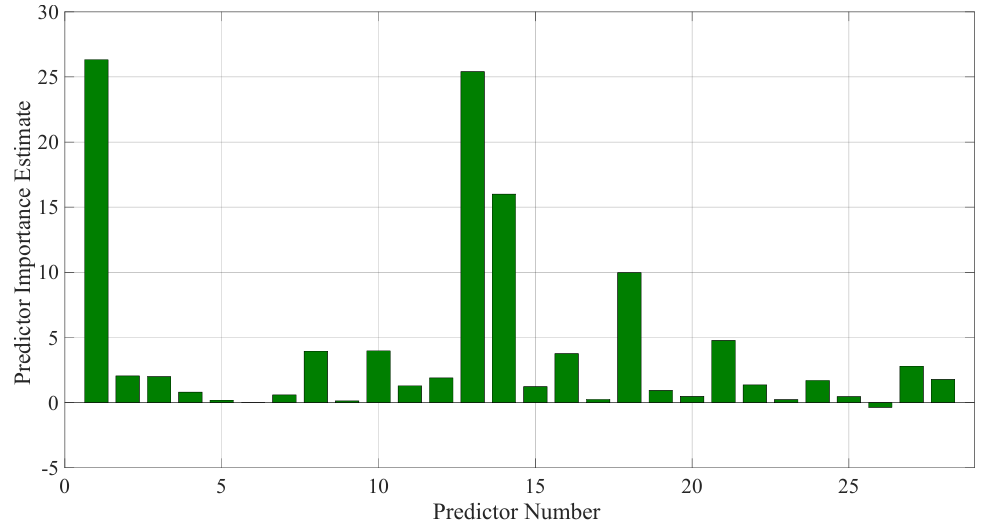
Figure 8. The estimated predictor importance measurements using the built in MatLab functions averaged across multiple iterations, feature depths and number of trees using two distinct functions- TreeBagger and